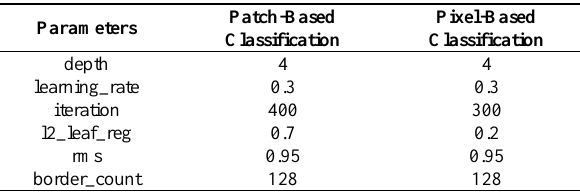
Table 3. Parameter values of CatBoost